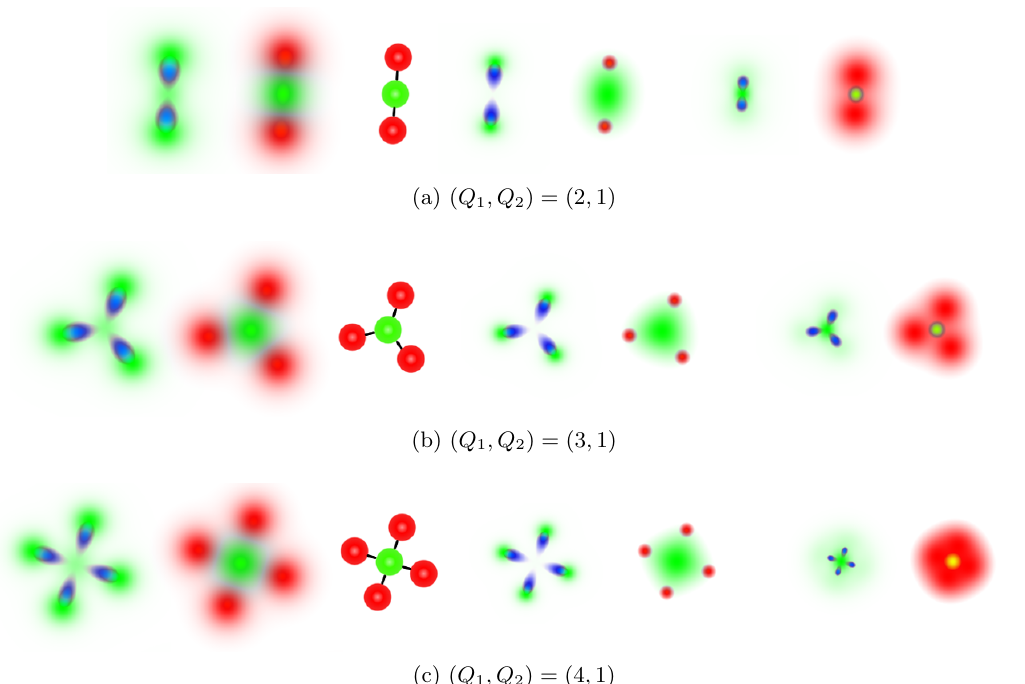
Figure 16 : ( Q 1 ; Q 2 ) = ( Q; 1) minimal vortex \(cid:13)owers", with Q = 2 ; 3 ; 4. Each sub(cid:12)gure contains 7 elements from left to right: for column 1 through 3: v 1 =v 2 = 1: an energy density plot, a (cid:12)eld density plot and a sketch of how the red and green vortices are interconnected. For column 4 and 5: v 1 =v 2 = 2: an energy density plot and a (cid:12)eld density plot. For column 6 and 7: v 1 =v 2 = 1 = 2: an energy density plot and a (cid:12)eld density plot. All columns except column 3 are made using the coloring scheme of (cid:12)gure